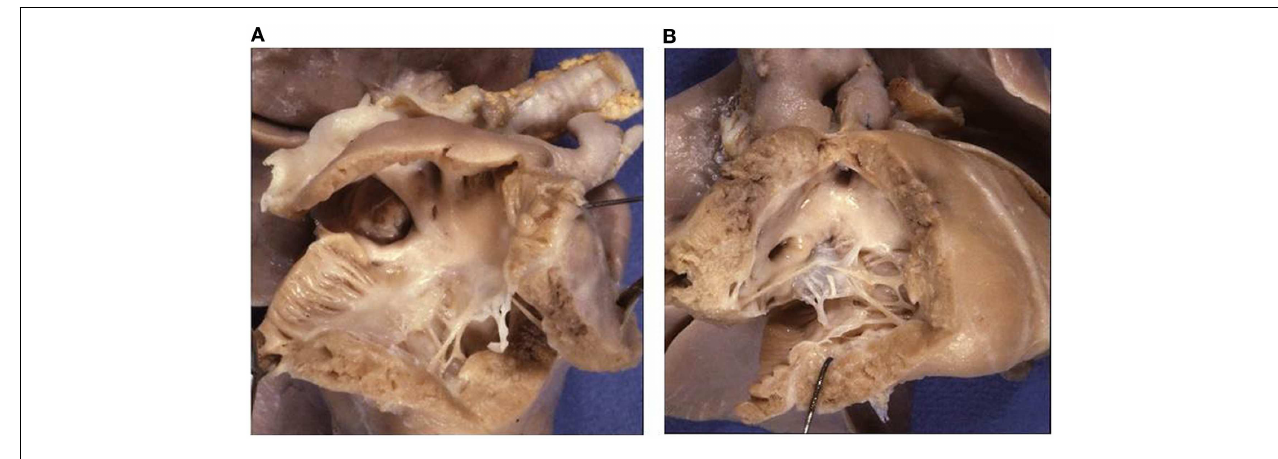
of the same case: note the endocardial fibroelastosis of the diminutive right ventricle.This heart may be suitable for one and half ventricle